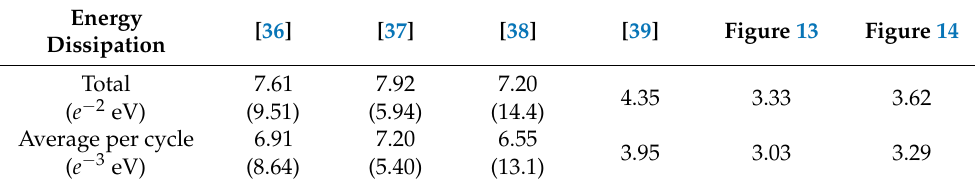
Table 9. Energy dissipation comparison of QCA 4-bit LFSR